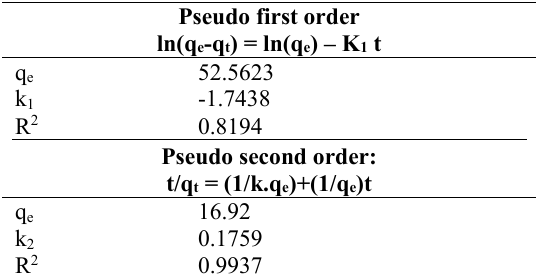
Table 2, Kinetic parameters values with R 2 for IC